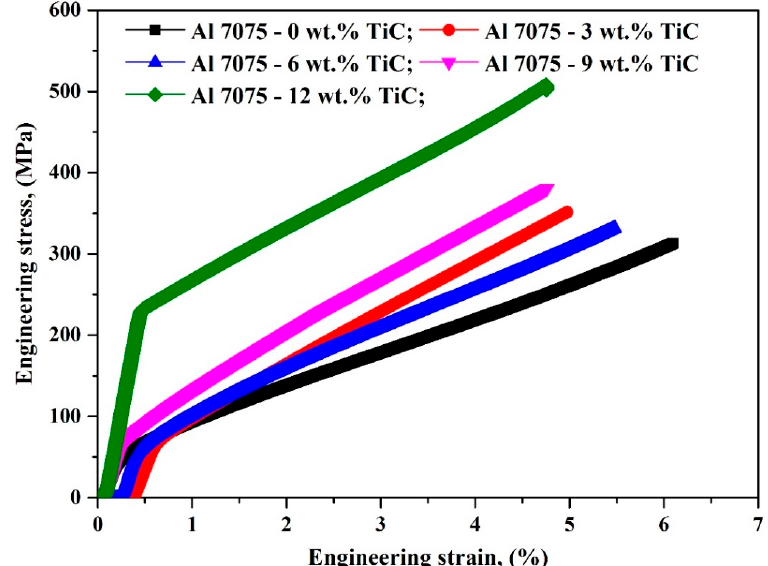
Figure 8. Compression behaviour of Al–TiC nanocomposites.